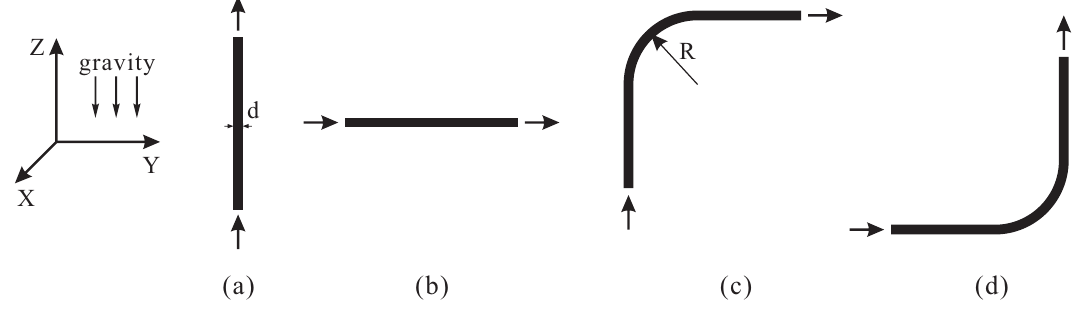
Figure 6. Four representative cases of pipe segment: ( a ) vertical straight pipe; ( b ) horizontal straight pipe; ( c ) upward elbow; and ( d ) downward